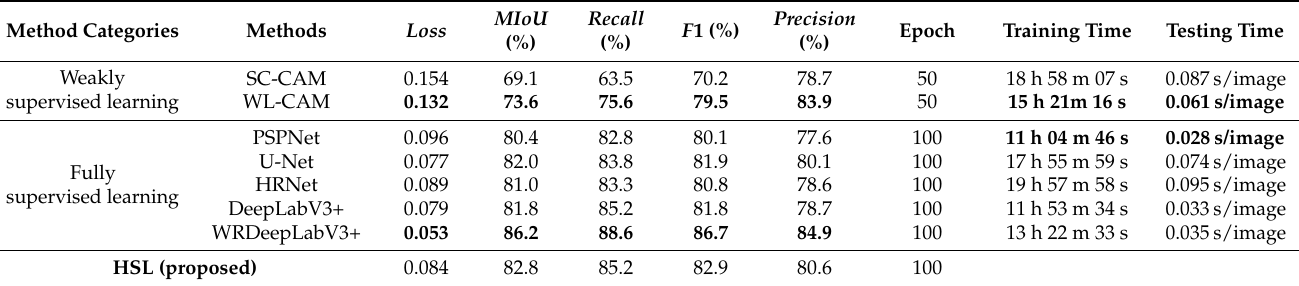
Table 7. Comparison of evaluation results of different semantic segmentation under the pro- posed